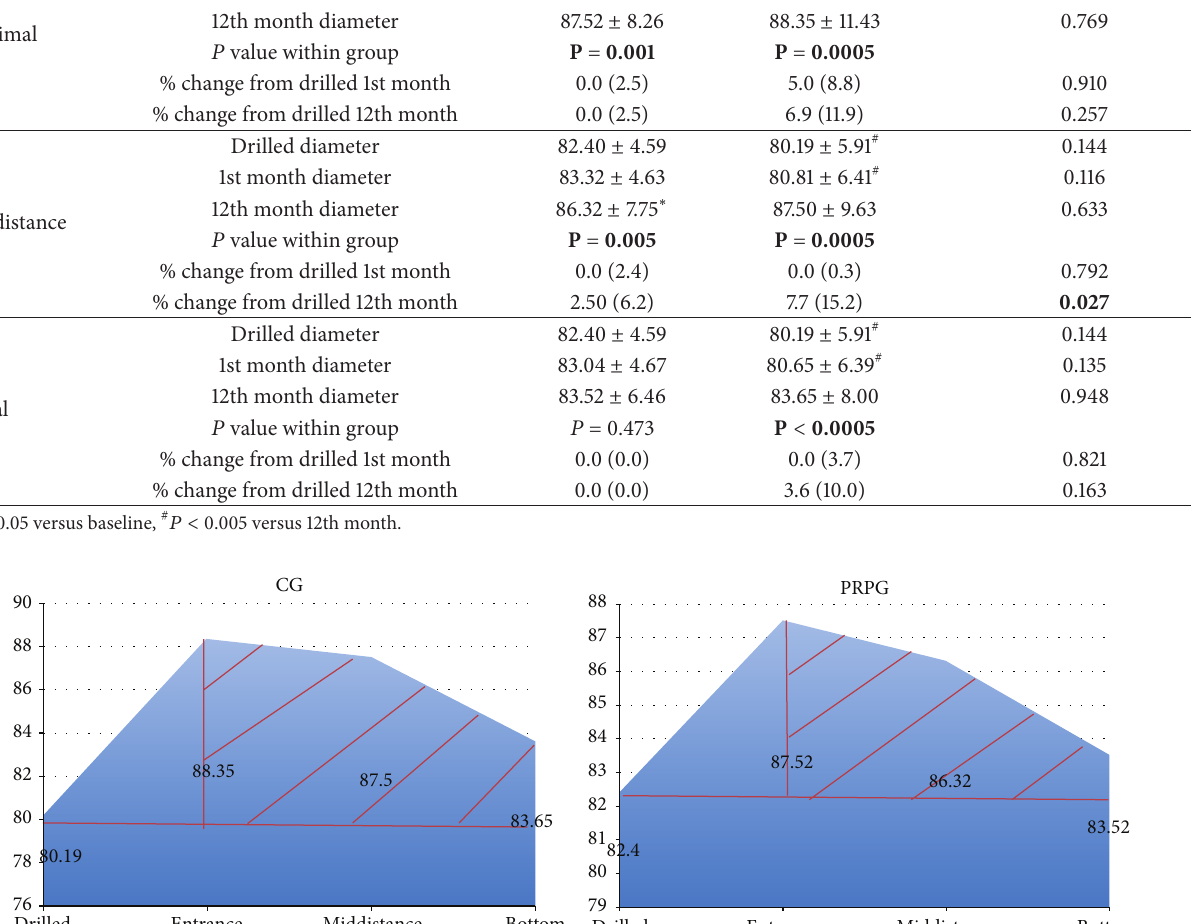
CG 𝑃 value between groups